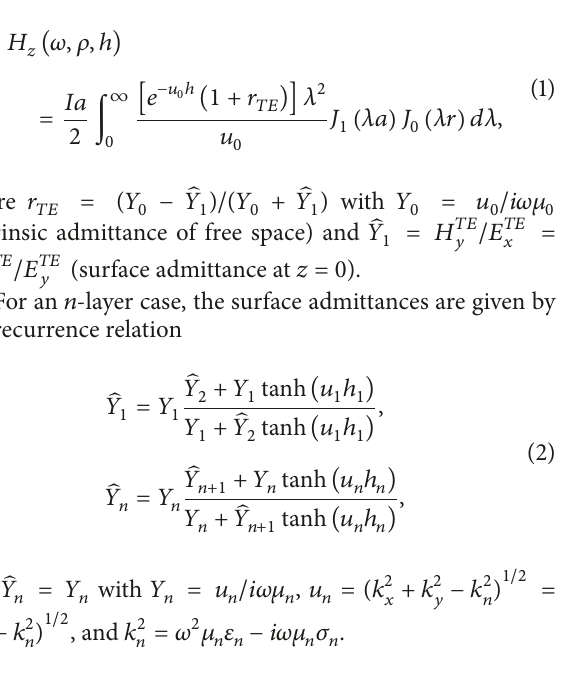
Here, 𝑟 is source-receiver offset (measured from the center of the loop). For calculation purposes, tanh (𝑢 𝑛 ℎ 𝑛 ) is used in its exponential form for stability reasons